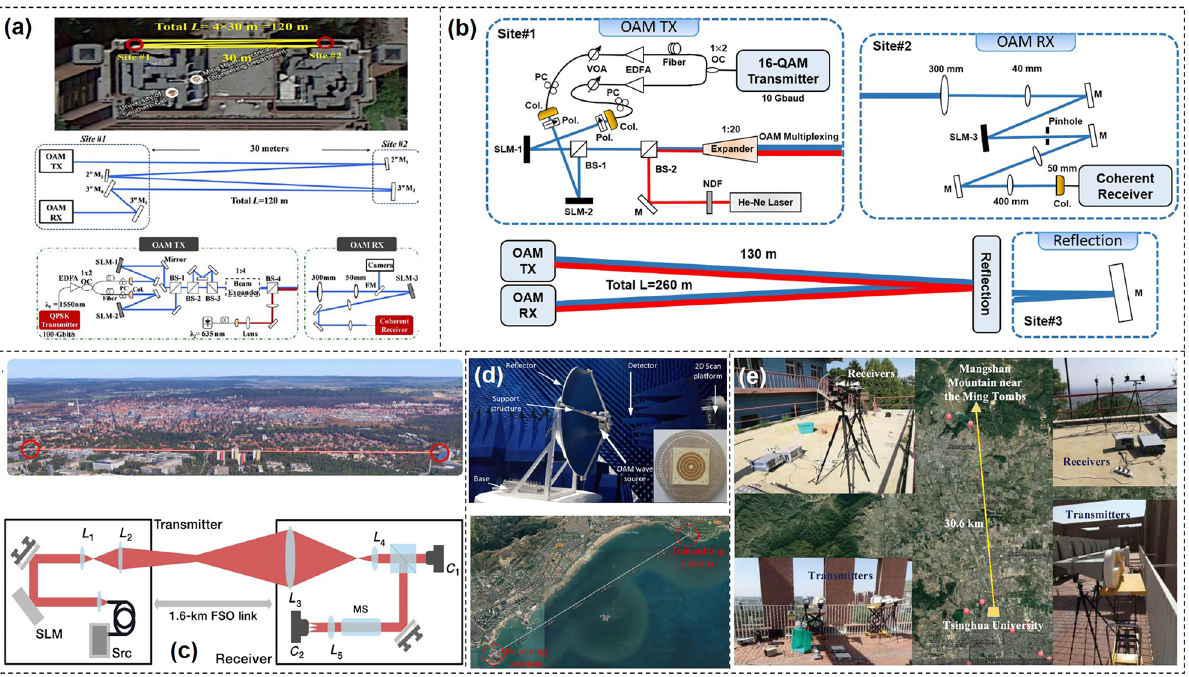
Figure 12: Real-world long-distance application scenario. (a) Experimental setup of a 120-m OAM-multiplexed link on a building roof [88]. (b) Experimental setup of a 260-m security OAM-multiplexed link[89].(c)1.6-kmfree-spacelinkoverthecityofErlangeninGermany[90].(d)StructureoftheOAMwavesourceontheparabolicre fl ectorfor long-distance transmission [91]. (e) OAM nondegenerate index mapping for long-distance transmission [92]. Reprint permission obtained from [88 –